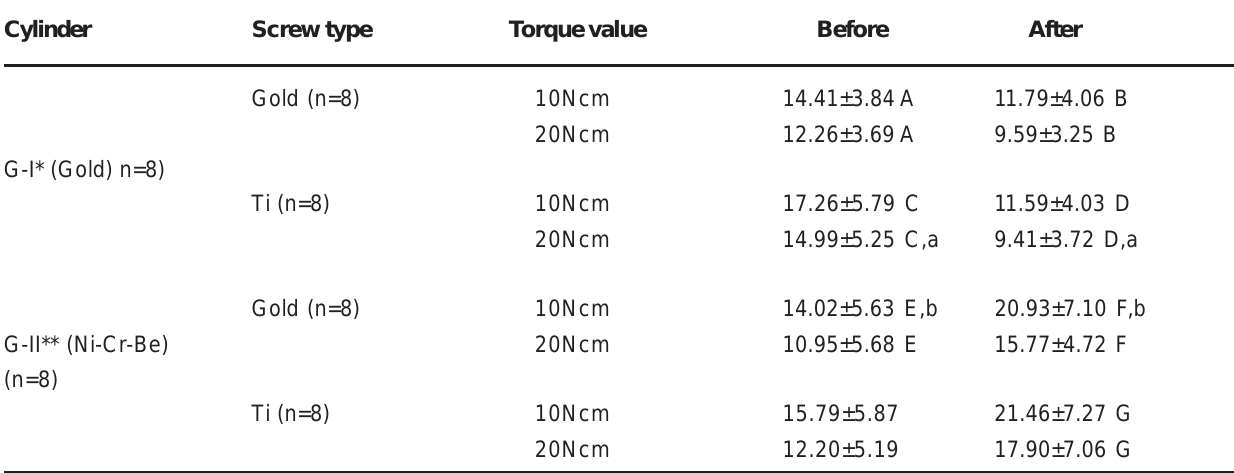
Mean values with the same letters indicate statistically significant differences (p<0.05) Capital letters represent intergroup comparisons within the same column. Small letters represent intragroup comparisons within the same